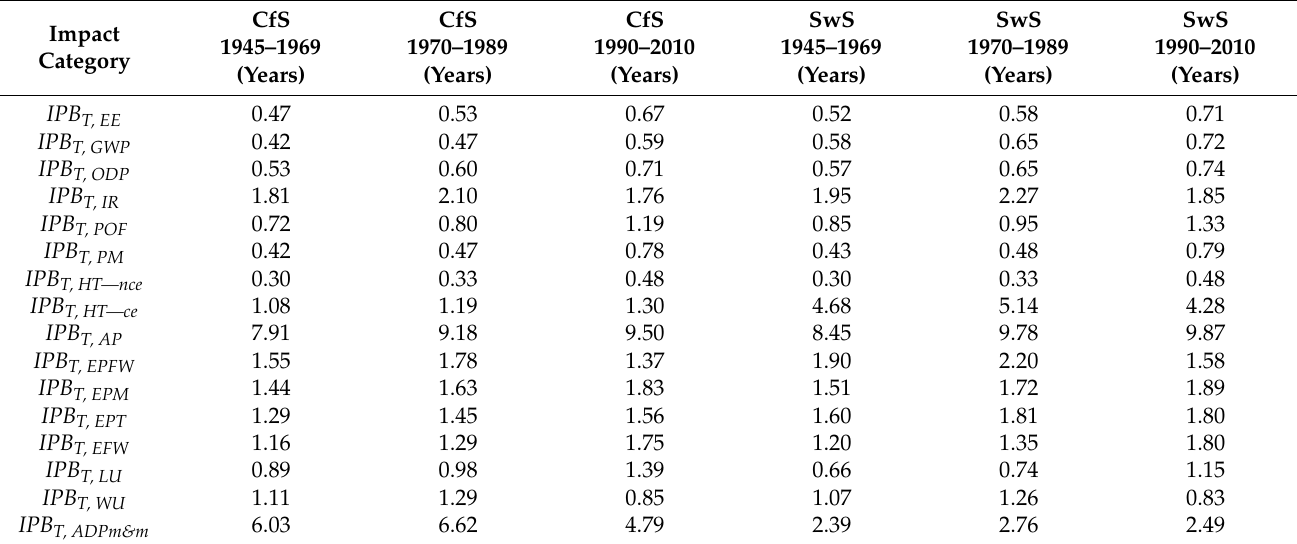
Table 7. Energy and environmental payback times of the retrofit action—CfS and SwS.